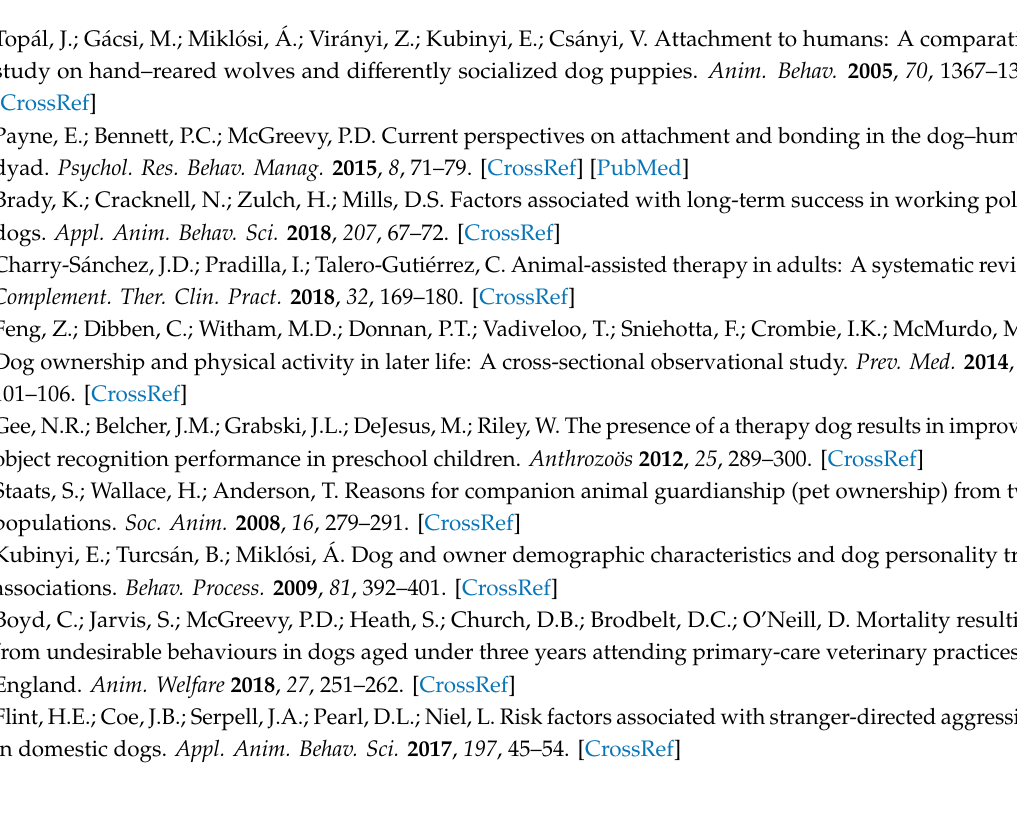
Table S1: Score sheet for